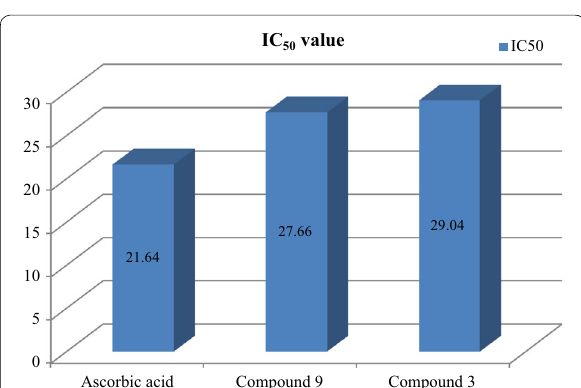
Fig. 7 IC 50 values of compound 3 and 9 compared to ascorbic